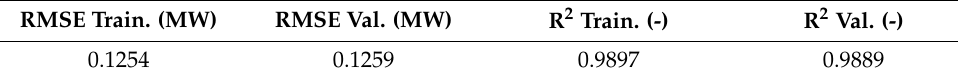
Table 1. Computed RMSE and R 2 indexes’ values for the persistence model. RMSE Train. (MW) RMSE Val. (MW) R 2 Train.